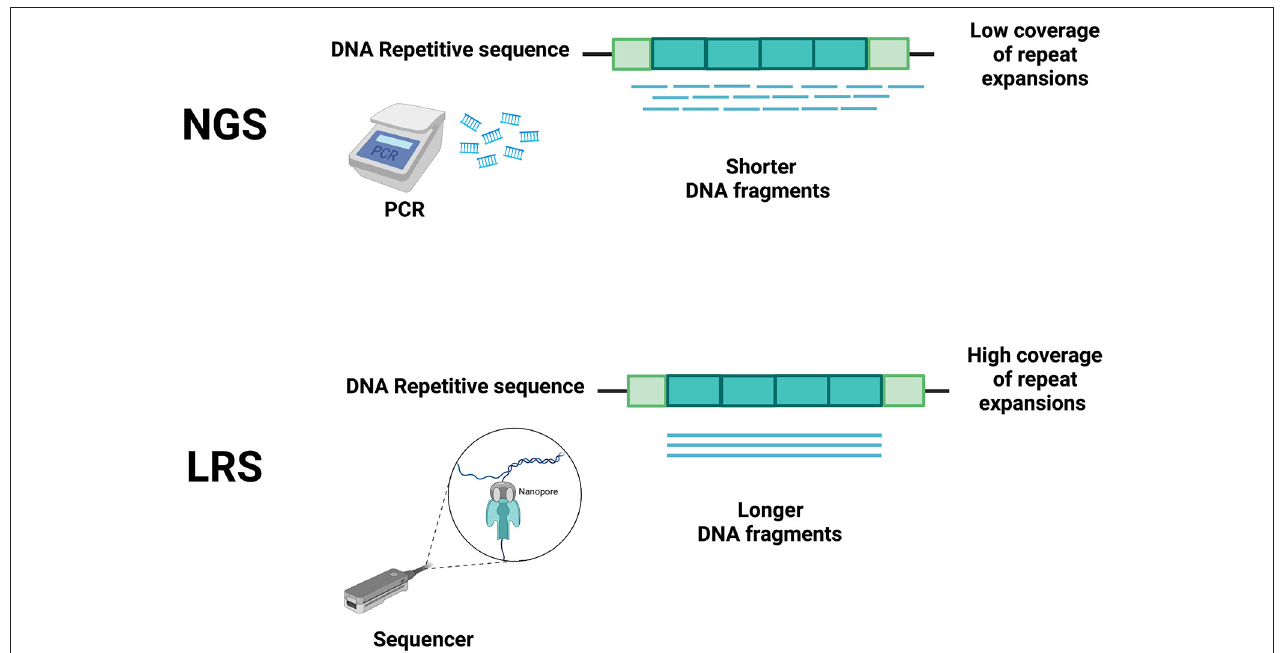
FIGURE 1 | Main differences between short-read next-generation sequencing (NGS) and long-read sequencing (LRS) technologies. Short-read NGS (upper panel) uses PCR to obtain short DNA fragments that do not accurately cover the whole repeated DNA sequence, thus allowing many interpretation errors (e.g., including edge of repeat and flanking regions, spanning boundaries of repeats). The differing technology of LRS (lower panel) does not require PCR, allowing a more accurate coverage of the repeated DNA sequence. Created with BioRender.com.